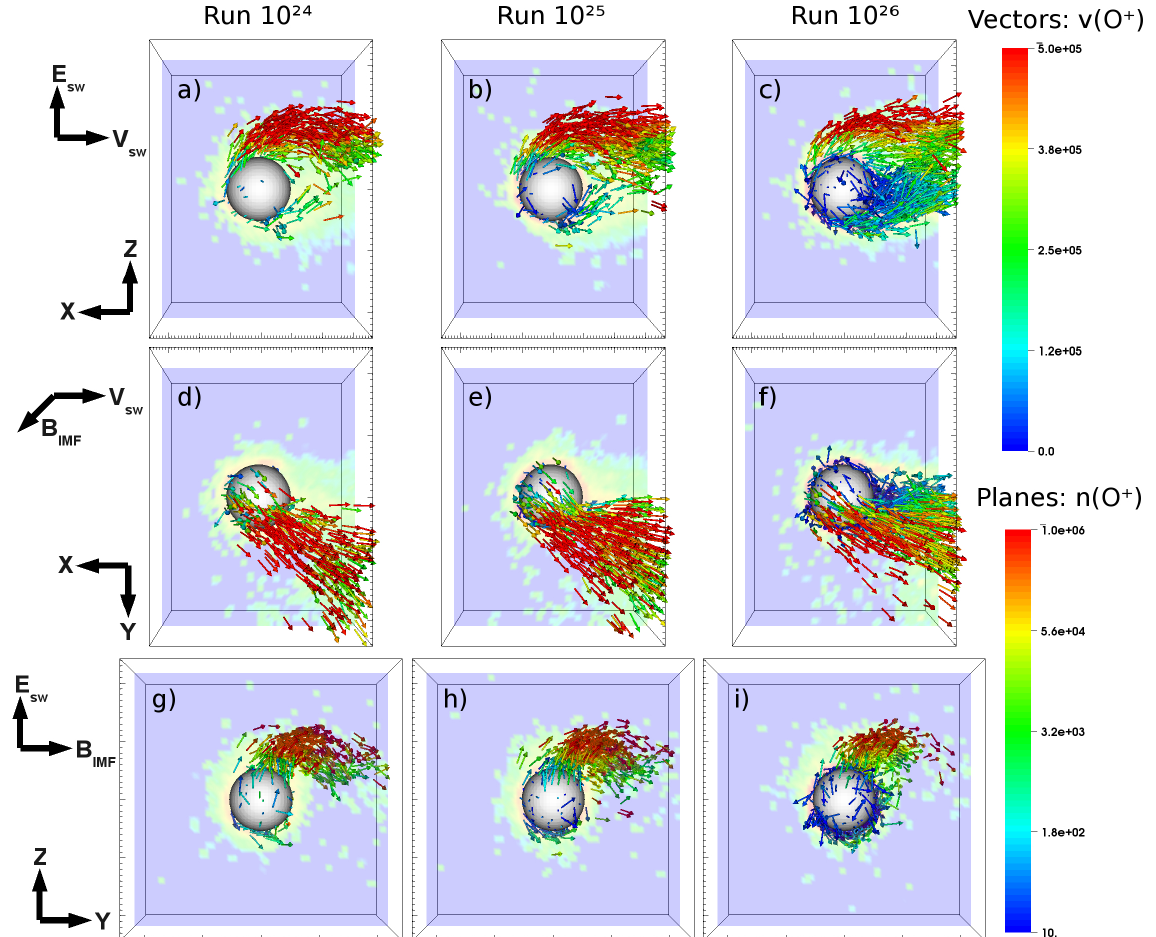
Fig. 9. Morphology and energy of the O + flow in three HYB-Venus simulation runs with different O + are (from the left): 10 24 , 10 25 (nominal) and 10 26 s − 1 . Background coloring shows the O + density at the y = 0, z = 0 and x = 0 planes. Topmost planes show a view towards the planet from the positive y-axis, middle row panels from the +z-axis and bottom panels from the +x-axis. Vectors show the O + velocity in regions with high bulk flux of O + ( nv > 10 10 m − 2 s − 1 ). The vectors are normalized to the unit length and the coloring gives the